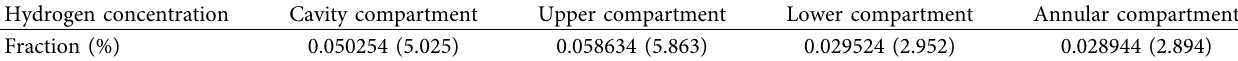
Table 17: Peak values of hydrogen mole fraction.